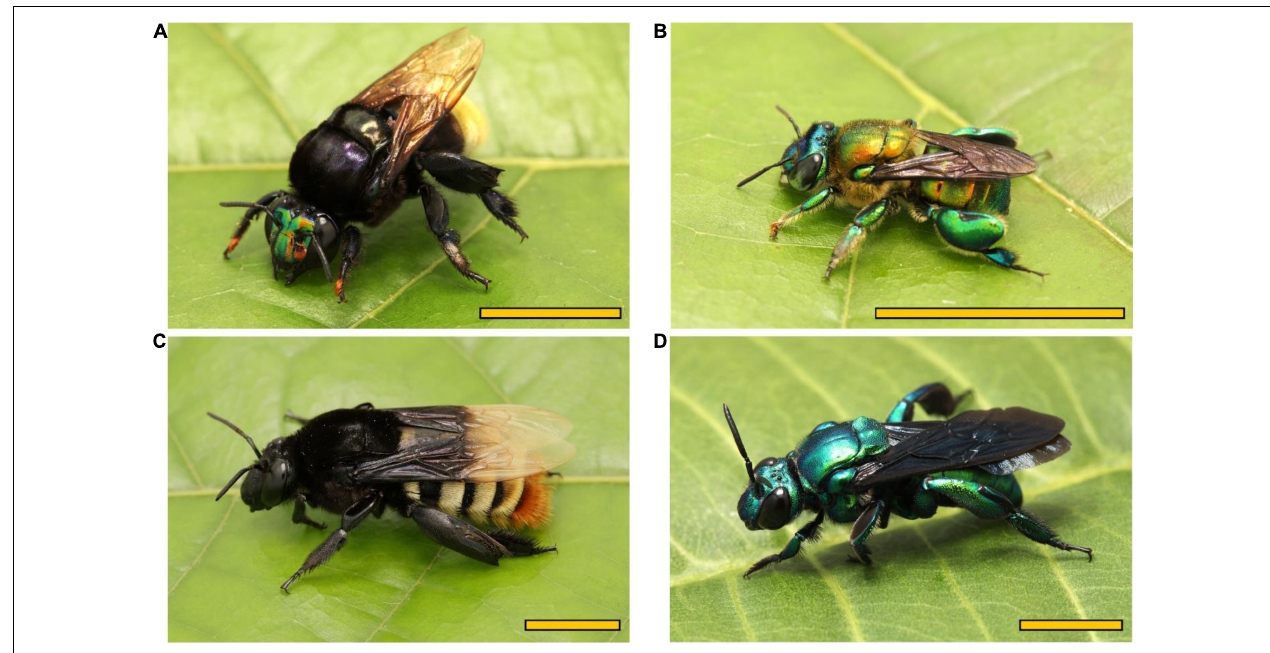
FIGURE 1 | Overview of the four tested euglossine genera (A) Eufriesea , (B) Euglossa , (C) Eulaema , and (D) Exaerete . Scale bar: 1 cm. Photos by Paulo